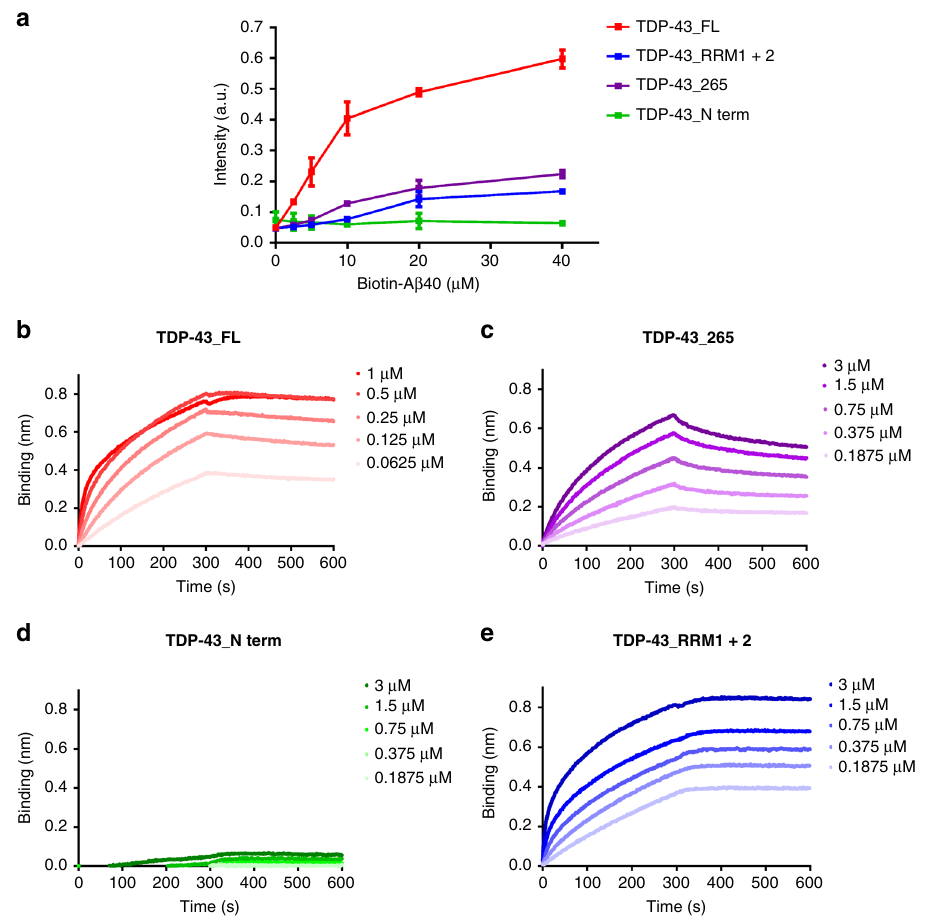
Fig. 3 Interaction of TDP-43 variants and A β . a Interaction of A β with TDP-43 variants was determined by ELISA. TDP-43 proteins were coated and detected by different concentrations of biotinylated A β . The averaged data from three replicates and standard deviations are plotted (TDP-43_FL, red; TDP- 43_265, purple; TDP-43_N-term, green; TDP-43_RRM1 + 2, blue). b – e Binding response between A β 40 and TDP-43 variants in biolayer interferometry analysis. TDP-43 at different concentrations ( μ M) were prepared and subjected to biolayer interferometry analysis by using Octet RED96 System (Pall ForeBio). The real-time binding response (nm) was measured in seconds. The loading amounts of A β 40 are the same for all the experiments. Source data are provided as a Source Data fi le. Table 1 Af fi nity of TDP-43 variants and A β interaction. The rate constants k on , k off , and K D de fi ned as k off / k on were determined by Octet RED96 system to probe the interaction between TDP-43 and A β 40.